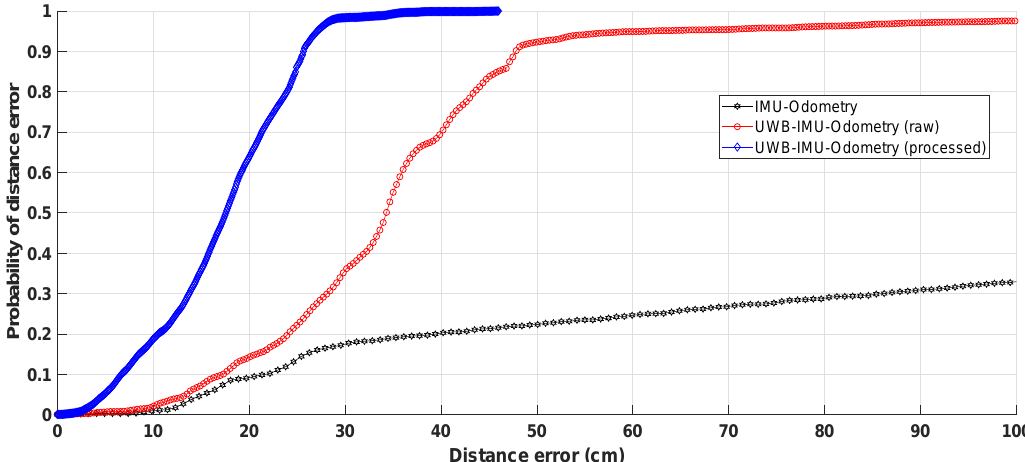
Figure 16. Accumulative distribution function of the UWB and the odometry and IMU positioning